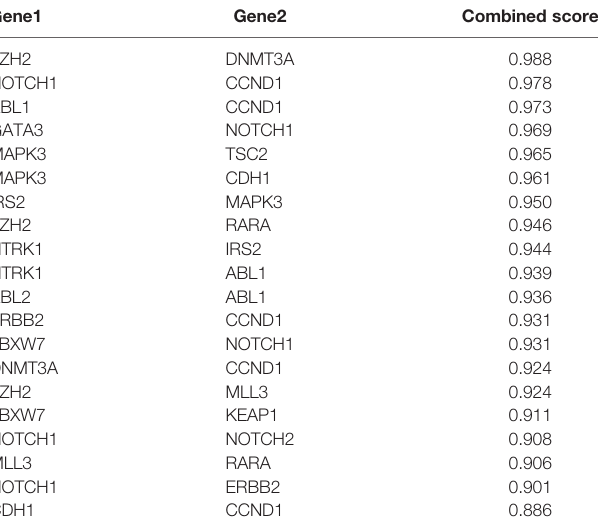
TABLE 2 | The top 20 pairs of the PPI network with high combined score.